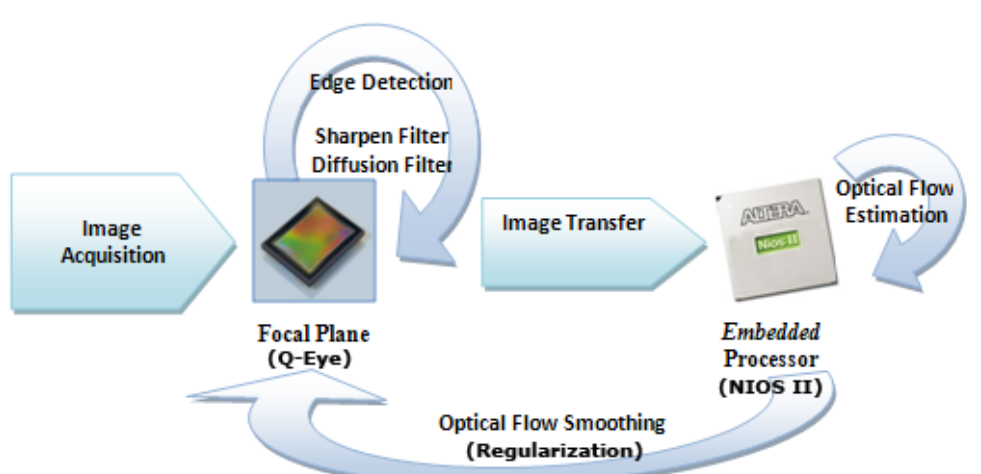
Figure 7. Initial Co-Design